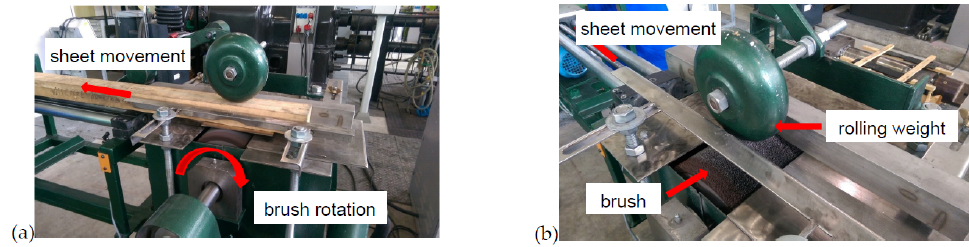
Figure 1. Stationary brushing machine at the IMF ( a ) Overview; ( b ) Detail. Table 2. Brushing parameters used in the experiments and roughness. Table 2. Brushing parameters used in the experiments and roughness. Brushing